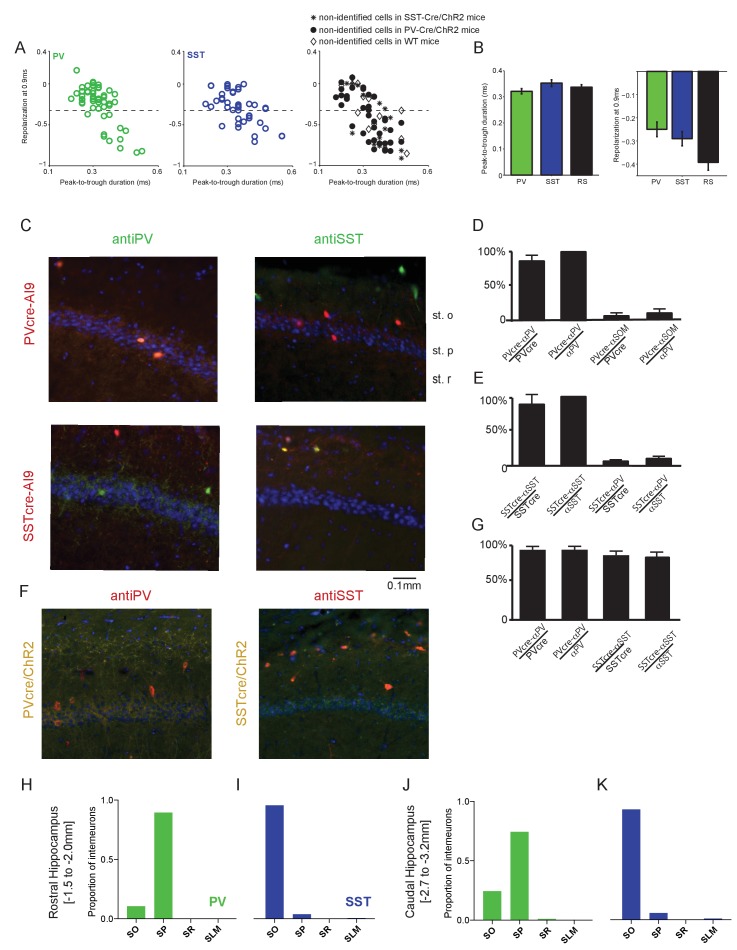
Spike waveform properties and histological characterization of hippocampal CA1 interneurons.(A) Average action potential waveforms of units plotted using their peak-to-trough duration in ms (x-axis) against their repolarization value at 0.9 ms (y-axis; see Materials and methods) for PV, SST and non-identified cells. Non-identified, ChR2-negative cells were recorded in experiments using PV-Cre, SST-Cre, or wild-type mice. RS cells were defined as cells having a repolarization value smaller than −0.35 (dotted lines). Note that the RS population may potentially include a small number of unidentified interneurons. (B) Mean peak-to-trough duration (left) and repolarization at 0.9 ms (right) were not significantly different across the three populations. (C) The two interneuron populations of interest were verified by crossing PV-Cre or SST-Cre mice with a red reporter line (Ai9) to express tdTomato in PV- or SST-expressing cells, respectively. Upper: Representative coronal sections from PV-Cre+/-Ai9f/- mice showing sparse cells immunostained for PV (green; Left) or SST (green; Right) in hippocampal CA1. Note the co-labeling with tdTomato in all PV-expressing cells and the absence of overlap in SST-expressing cells. Lower: In hippocampal sections from SST-Cre+/-Ai9f/- mice, note co-labeling for tdTomato in SST- (green; Right) but not PV-expressing (green; Left) cells. In all sections, DAPI counterstaining highlights the hippocampal CA1 anatomy (stratum pyramidale (st.p), stratum oriens (st.o) and stratum radiatum (st. (r)). (D) Bars showing the percentage of PV-expressing neurons that are fate mapped by the PV-CreAi9 line in mouse hippocampal CA1 (n = 3 independent brains for each genotype); percentage of PV-Cre/Ai9 fate mapped interneurons that express PV (n = 3 independent brains for each genotype); percentage of SST-expressing neurons that are fate mapped by the PV-CreAi9 line; and the percentage of PV-Cre/Ai9 fate mapped interneurons that express SST. Data represent mean ±SEM. (E) Same as for (D) but for SST-Cre/Ai9 mice (n = 3 independent brains for each genotype). Data represent mean ±SEM. (F) Representative images from a PV-Cre/ChR2 mouse (yellow) immunostained for PV (red, left) and a SST-Cre/ChR2 mouse (yellow) immunostained for SST (red, right). (G) Bars showing the percentage of Cre + neurons stained by antibody and percentage of Ab +neurons labeled by Cre for each mouse line. (H) In the rostral hippocampus where recordings were performed (AP −1.5 to −2.0 mm), the cell bodies of ~90% of PV interneurons identified by Cre-dependent expression of tdTomato were located in the stratum pyramidale (SP), with ~10% in the statum oriens (SO). (I) In the same rostral region, ~95% of SST interneurons had cell bodies located in the SO, with ~5% in the SP. (J) In contrast, PV cells caudal to the recording area (AP −2.7 to −3.2 mm) showed a different distribution, with ~75% of cell bodies in the SP and ~25% in the SO, along with a small number in the stratum radiatum (SR). (K) SST interneuron cell body distribution was similar along the rostral-caudal axis, with ~95% of cell bodies in the caudal CA1 located in the SO and a small number in the SP and stratum lacunosum moleculare (SLM). Data were collected from PV-Cre+/-Ai9f/- (n = 4) and SST-Cre+/-Ai9f/- (n = 4) animals.